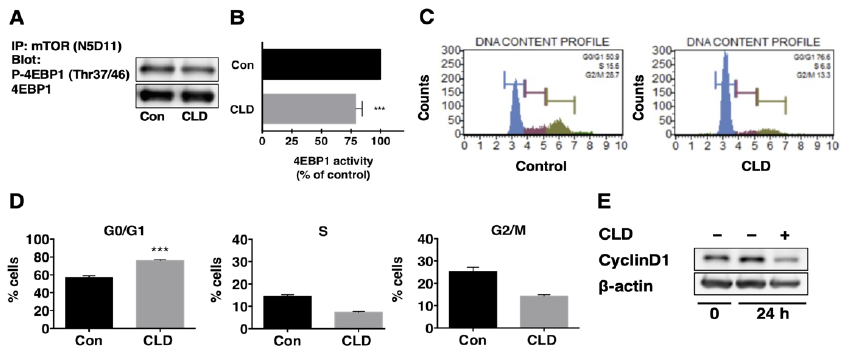
Figure 4. Direct effect of clindamycin on mTORC1 kinase activity and its involvement in the cell cycle progression at NGT41 cells. The in vitro kinase assay was examined in NGT41 cells. Cells were treated with a vehicle (control) or clindamycin (CLD) 440 µ M for 72 h. Cell lysates were immunoprecipitated with the anti-mTOR (N5D11) antibody. The immunoprecipitates were added 4EBP1 as a substrate and were subjected to SDS-PAGE. mTORC1 activity was evaluated via Western blotting using anti-phospho 4EBP1 at the Thr37/46 antibody ( A ). The intensity of the immunoreactive band was quantified after standardizing the ratio of phospho/total 4EBP1 ( B ). Data are shown